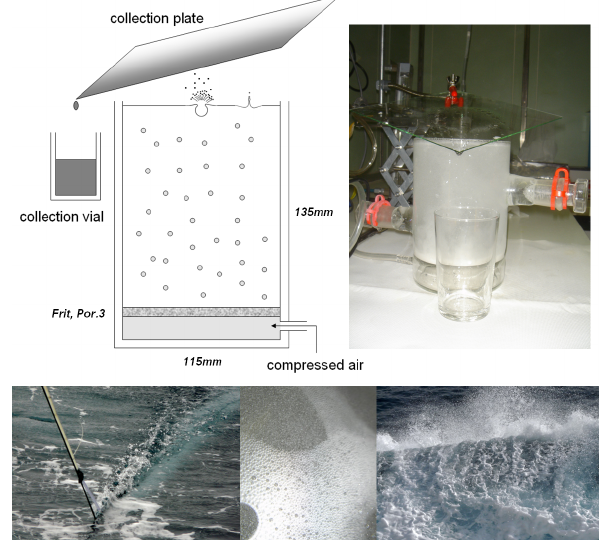
Fig. 2. Apparatus used for the generation and collection of the burst Figure 2: Apparatus used for the generation and collection of the burst generated freshly from generated freshly from the surface water. The water was collected the surface water. The water was collected with the “fish” sampler in the surface of the water layer (left); bursting bubbles at the surface of the chamber (middle) and on sea water surface with the “fish” sampler in the surface of the water layer (left); burst- of the ocean (right). ing bubbles at the surface of the chamber (middle) and on sea water surface of the ocean